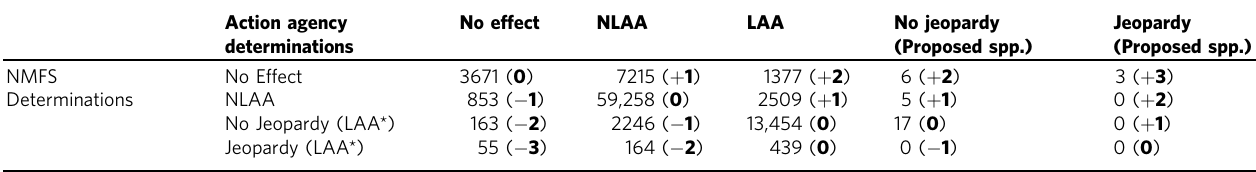
Table 1 Frequencies of determinations proposed by action agencies vs. fi nal determinations made by NMFS during section 7 consultation from 2000 to 2017